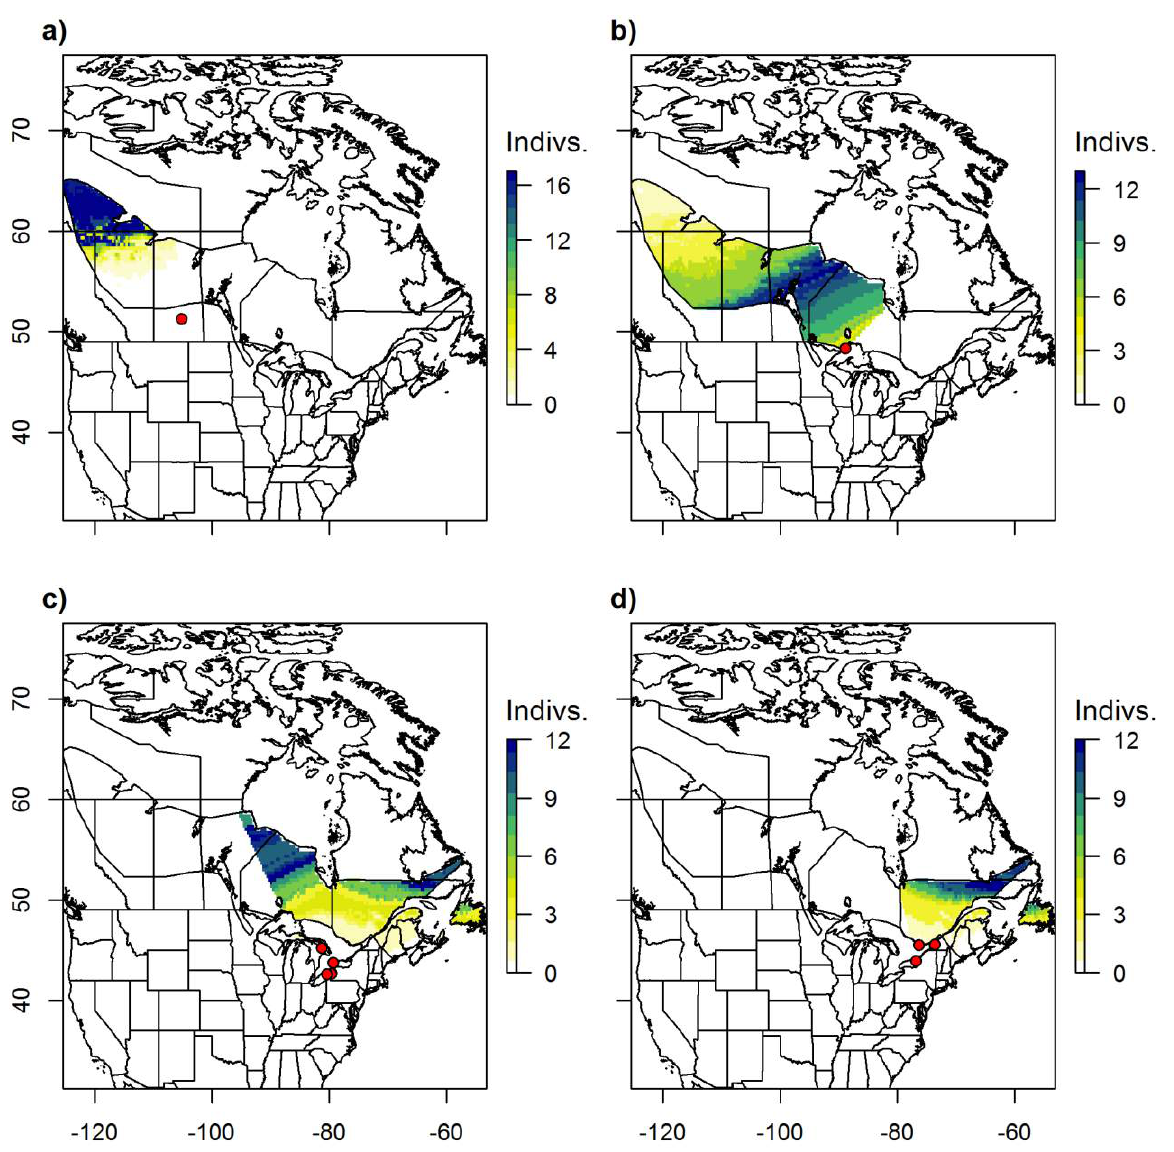
Figure A2.18: Probable origins of Palm Warblers ( Setophaga palmarum ) captured during fall migration at CMMN stations in a) Saskatchewan (LMBO (n=17)); b) Western Ontario (TCBO (n=20)); c) Southwest Ontario (AuBO (n=2), HBO (n=3), LPBO (n=10), TTPBRS (n=5)); and d) Southeast Ontario and Southwest Québec (MBO (n=14), PEPTBO